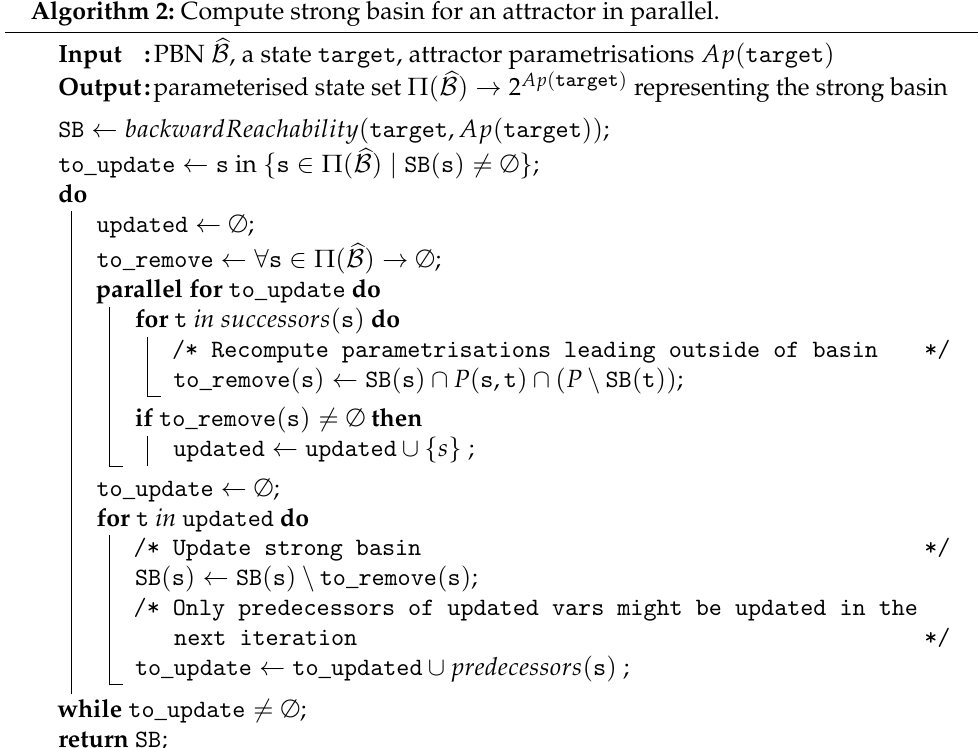
Algorithm 2: Compute strong basin for an attractor in